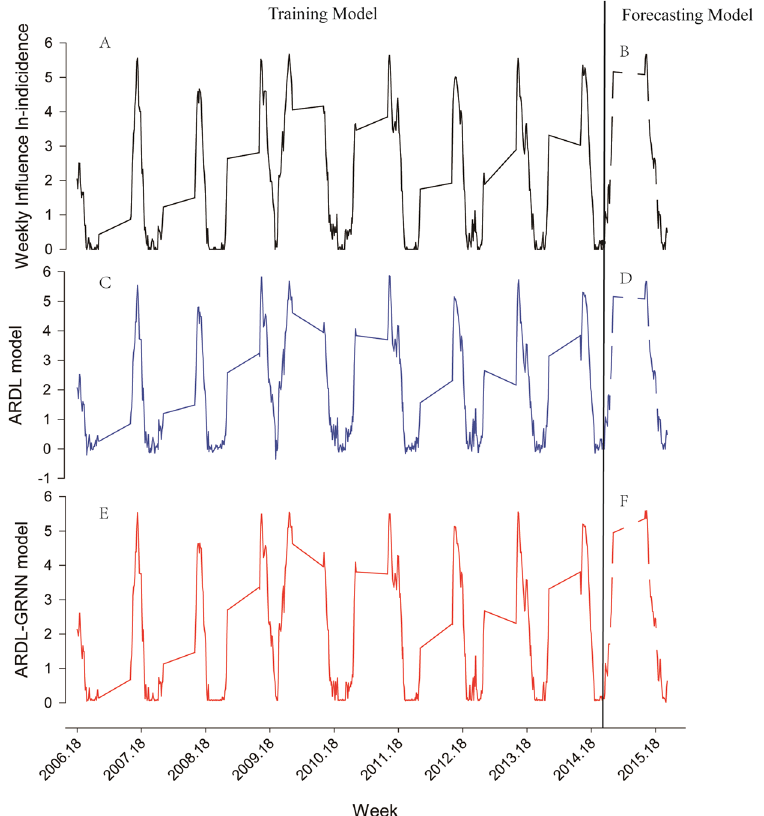
Figure 4. Comparison of actual, predicted and forecasted week incidence of influenza in Nagasaki prefecture, Japan. Training model includes: Actual weekly incidence of influenza by training model ( A ), Best-fitting ARDL training model ( C ), and ARDL-GRNN training model ( E ). Forecasting model includes: Actual weekly incidence of influenza by forecasting model ( B ), Besting-fitting ARDL forecasting model ( D ), and ARDL- GRNN forecasting model ( F ).